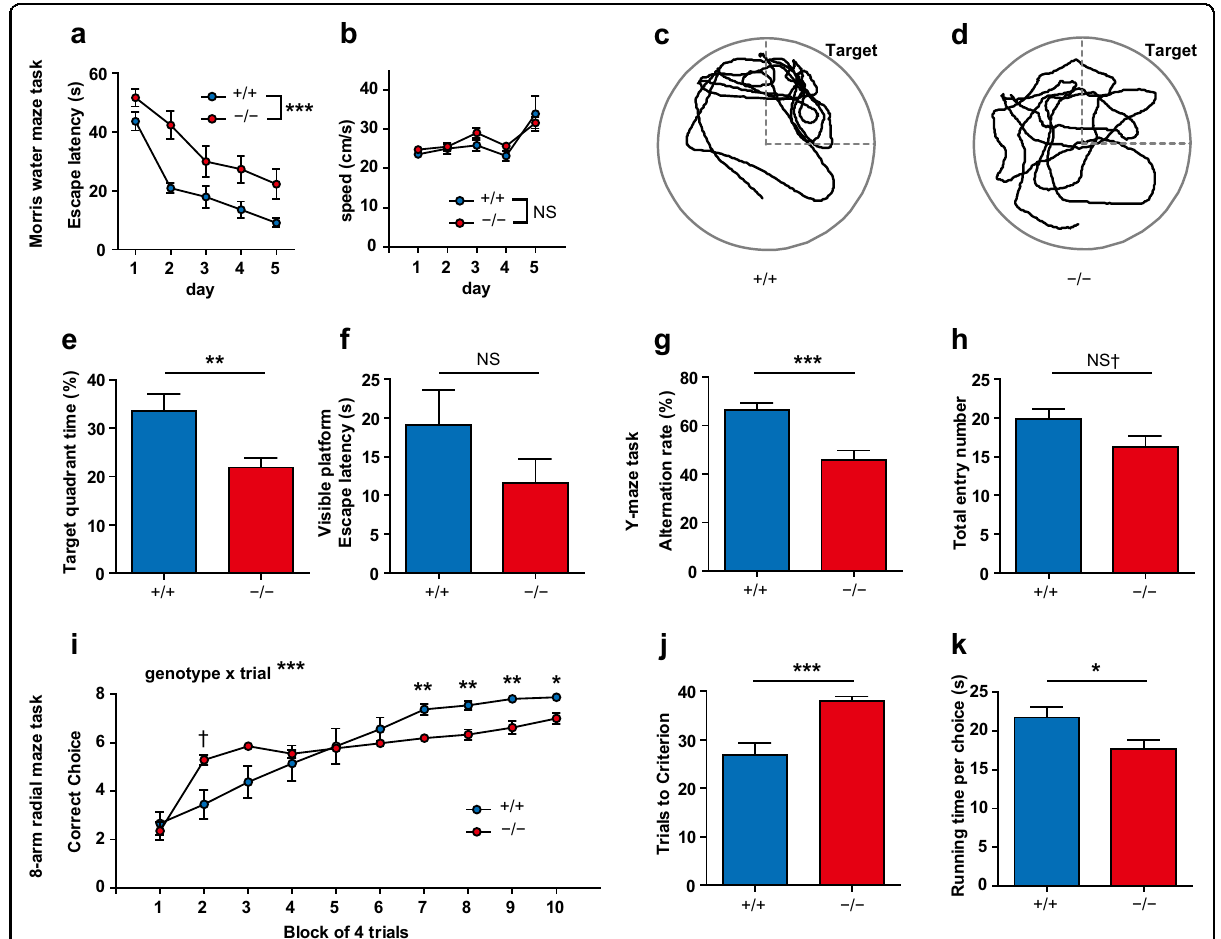
Fig. 5 Spatial cognitive impairments in Gad1 − / − rats. Gad1 − / − rats displayed signi fi cant cognitive impairments in multiple tasks. a – f Morris water maze task ( Gad1 + / + , n = 12; Gad1 + / + , n = 12). Gad1 − / − rats required a longer time to reach the hidden platform during the 5-day training period (main effect of genotype, F (1, 22) = 20.4574, p < 0.001) ( a ). However, the swimming speed of the Gad1 − / − rat was very similar to that of the Gad1 + / + rat (main effect of genotype, F (1, 22) = 0.5307, p = 0.4740) ( b ). Representative trajectories of Gad1 + / + ( c ) and Gad1 − / − ( d ) rats in the probe test. The target quadrant is shown in the panels. In Gad1 − / − rats, the accumulation of the trajectory to the target was decreased. The percentage of time spent within the target quadrant was signi fi cantly reduced in Gad1 − / − rats compared with Gad1 + / + rats ( t (17.033) = − 2.9599, p < 0.01) ( e ). There was no signi fi cant difference between genotypes in the visible platform task ( t (19.591) = − 1.3764, p = 0.1842) ( f ). g – h Y-maze test for working memory ( Gad1 + / + , n = 12; Gad1 + / + n = 11). Gad1 − / − rats showed less alternation behavior than Gad1 + / + rats ( t (18.877) = – 4.0583, p < 0.001) ( g ). The number of entries to arms was also slightly decreased in Gad1 − / − rats ( t (20.453) = – 1.8815, p = 0.07422) ( h ). i – k Eight-arm radial maze task for working memory ( Gad1 + / + , n = 12; Gad1 − / − , n = 12). Gad1 − / − rats showed a different pattern in the learning curve from that of Gad1 + / + rats (genotype × trials, F (9, 198) = 9.1844, p < 0.001). At the end of the training, the number of correct choices was less in Gad1 − / − rats than in Gad1 + / + rats (simple main effects of genotype, adjusted by Holm ’ s method; 7th to 9th, p < 0.01; 10th, p < 0.05). However, in the second block, Gad1 − / − rats transiently scored higher than WT rats (2nd, p = 0.05227) ( i ). Gad1 − / − rats also needed more trials to reach the learning criterion of the task ( t (13.78) = 4.3409, p < 0.001) ( j ). Running time per choice was decreased in Gad1 − / − rats ( t (21.868) = 2.3065, p < 0.05) ( k ). The results are presented as the average ± SEM. Data were analyzed using two-way repeated measures ANOVA ( a , b , i ) and Welch ’ s t -test ( e – h , j , k ). † p < 0.1, p < 0.05, ** p < 0.01, *** p < 0.001; NS, not signi fi